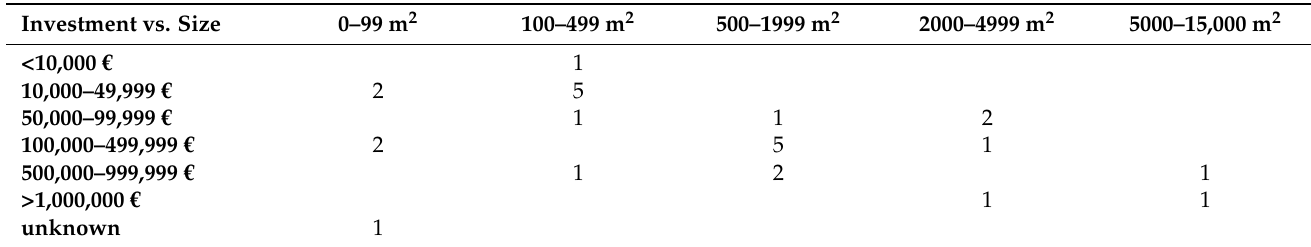
Table 2. Initial investment range according to the size range of the aquaponic system. Investment vs.